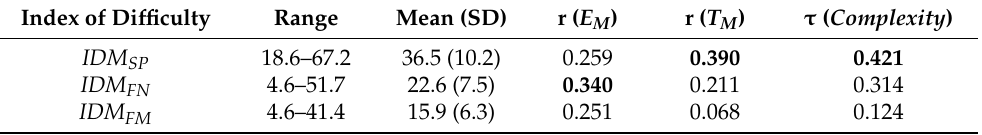
Table 3. Descriptive statistics and correlations for the different formulations of the index of